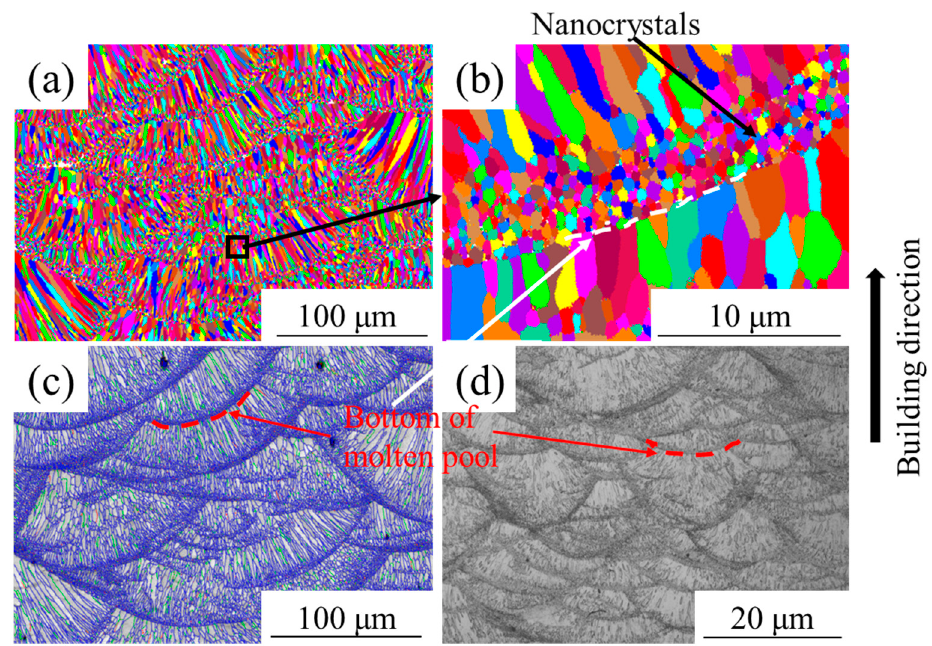
Figure 6. The metallographic structure and EBSD analysis of the vertical section of sample 4 in the as-printed status, ( a ) grain reconstruction map, ×400, ( b ) grain reconstruction map, ×5000, ( c ) grain boundary reconstruction map, ( d ) metallographic photograph.